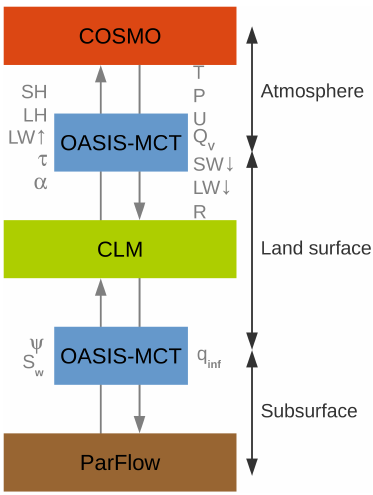
Figure 1. Coupling of the TerrSysMP component models ParFlow (subsurface), CLM (land surface) and COSMO-DE (atmosphere) by OASIS-MCT. The exchanged fluxes and state variables are: ψ (subsurface pressure), S w (subsurface saturation), q inf (net infiltra- tion flux), SH (sensible heat flux), LH (latent heat flux), LW ↑ (out- going long-wave radiation), τ (momentum flux), α (albedo), P (air pressure), T (air temperature), U (wind velocity), SW ↓ (incoming short-wave radiation), LW ↓ (incoming long-wave radiation), Q V (specific humidity) and R